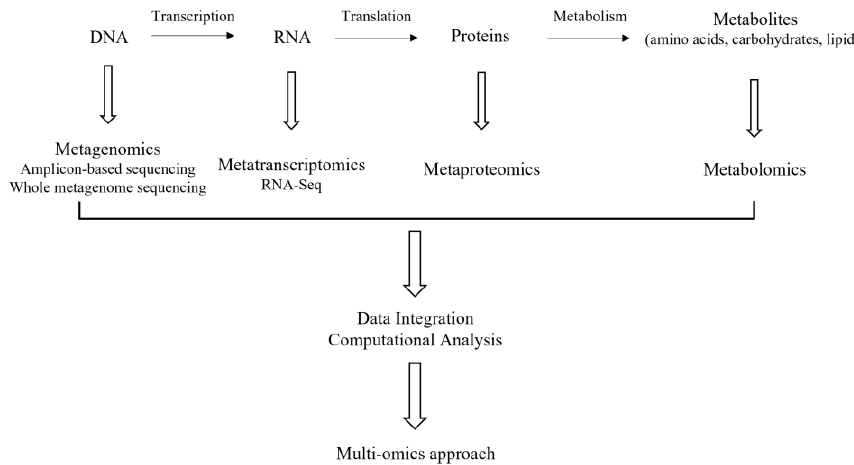
Figure 1. Integrating multi-omics approaches for the study of cheese flavor development.